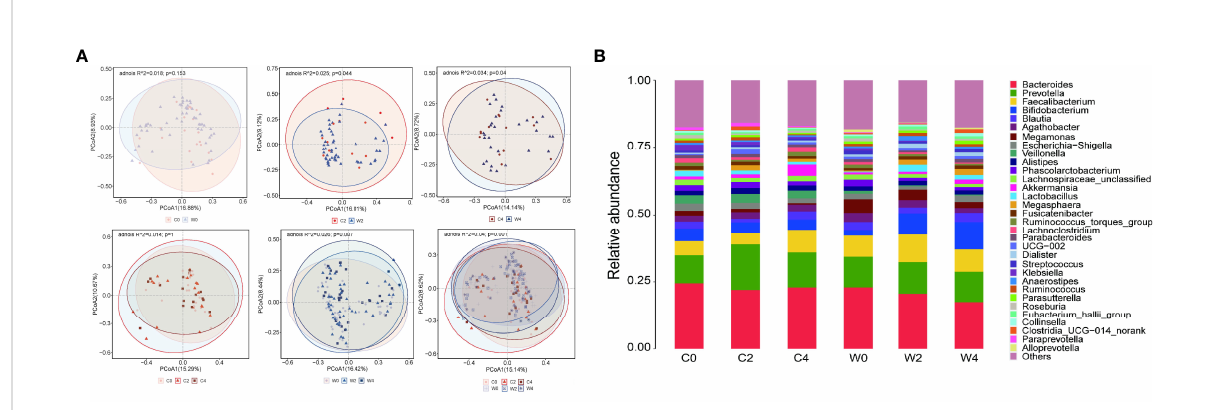
FIGURE 3 Effect of WCBE treatment on the gut microbiota structure. PcoA of fecal microbiota pre-intervention, 2 months post-intervention and 4 months post-intervention. Based on PERMANOVA statistical analysis, variations during the intervention, P = 0.001; C0 vs. W0, P > 0.05; C2 vs. W2, P <